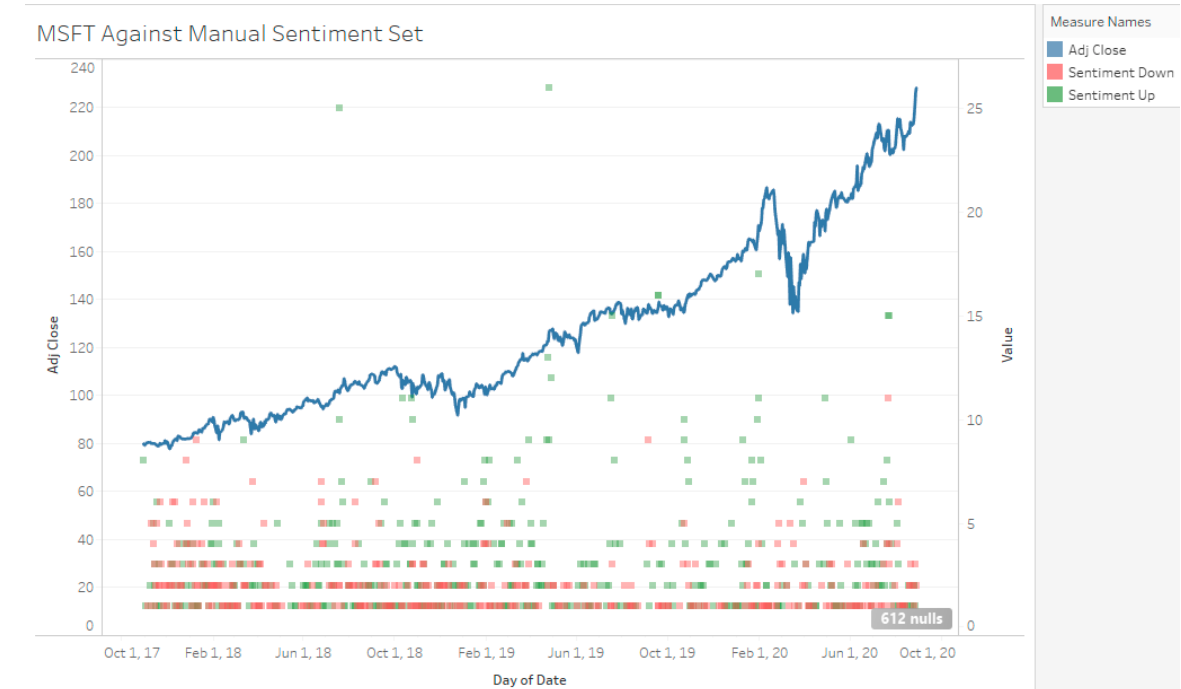
Figure 4. AAPL Stock Against Manual Sentiment.